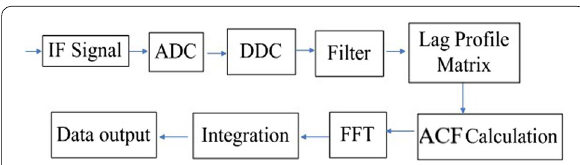
Fig. 7 Schematic diagram of the signal processing